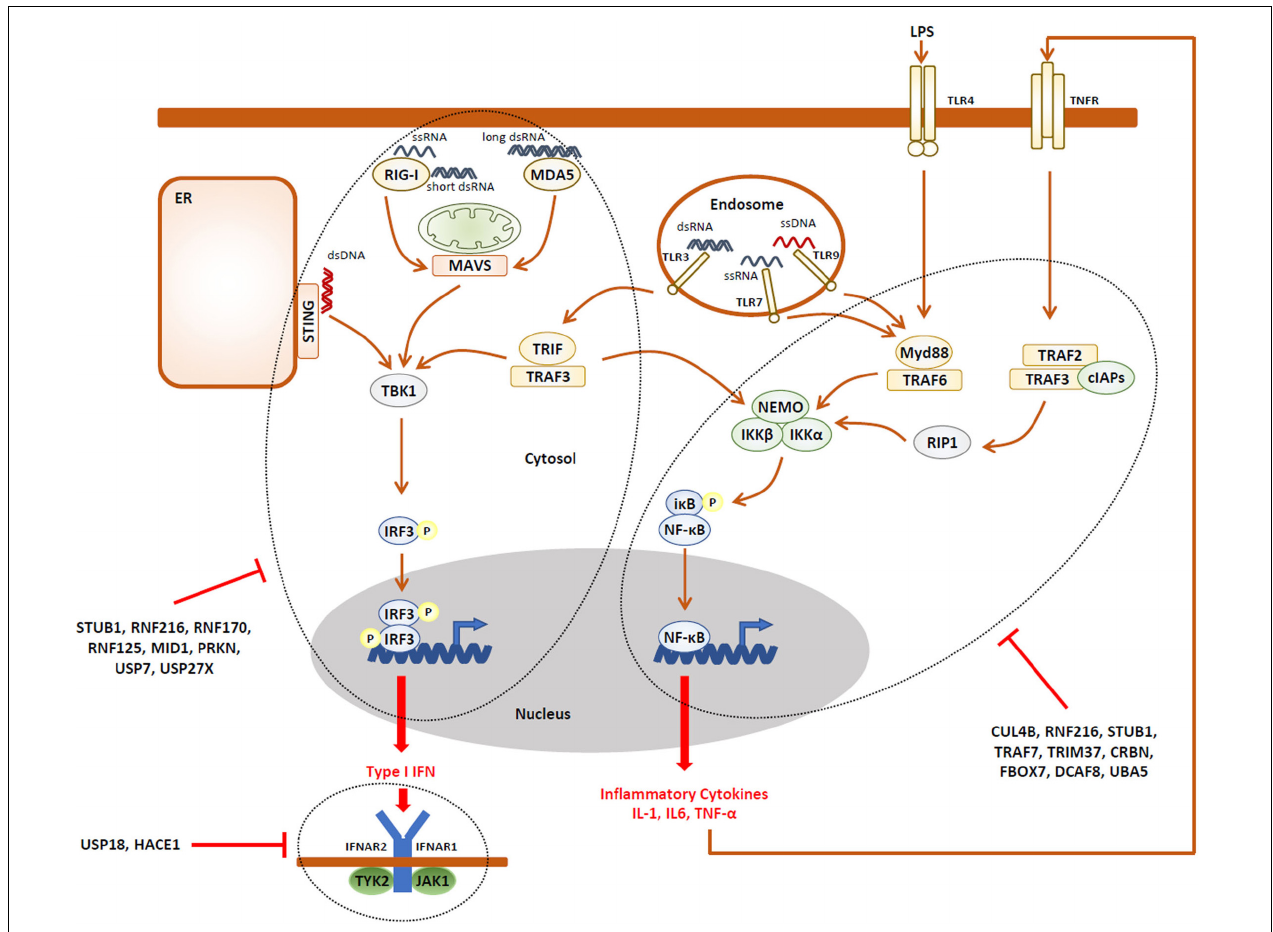
FIGURE 2 | A large fraction of the UPS gene products associated with NDD are negative regulators of the innate immune response. Activation of pathogen recognition receptors (PRR, i.e., TLR3, TLR4, TLR7, TLR9, RIG-1, MDA5, and STING) by pathogen-associated molecular patterns (PAMP, i.e., LPS, ssRNA, dsRNA, and CpG) results in the activation of intracellular signaling cascades which ultimately promote the nuclear translocation of the IRF3 and NF- κ B transcriptions factors, as indicated. These, in turn, directly induce the expression of pro-inflammatory cytokines (i.e., TNF- α ) and type I IFN which engage the innate arm of the immune system through autocrine and/or paracrine loops. Both the IRF3 and NF- κ B activation pathways are down-regulated by many components of the UPS which have been associated with NDD, as indicated. In addition, the autocrine/paracrine action of type I IFN is subjected to negative regulation by the UPS genes USP18 and HACE1, as